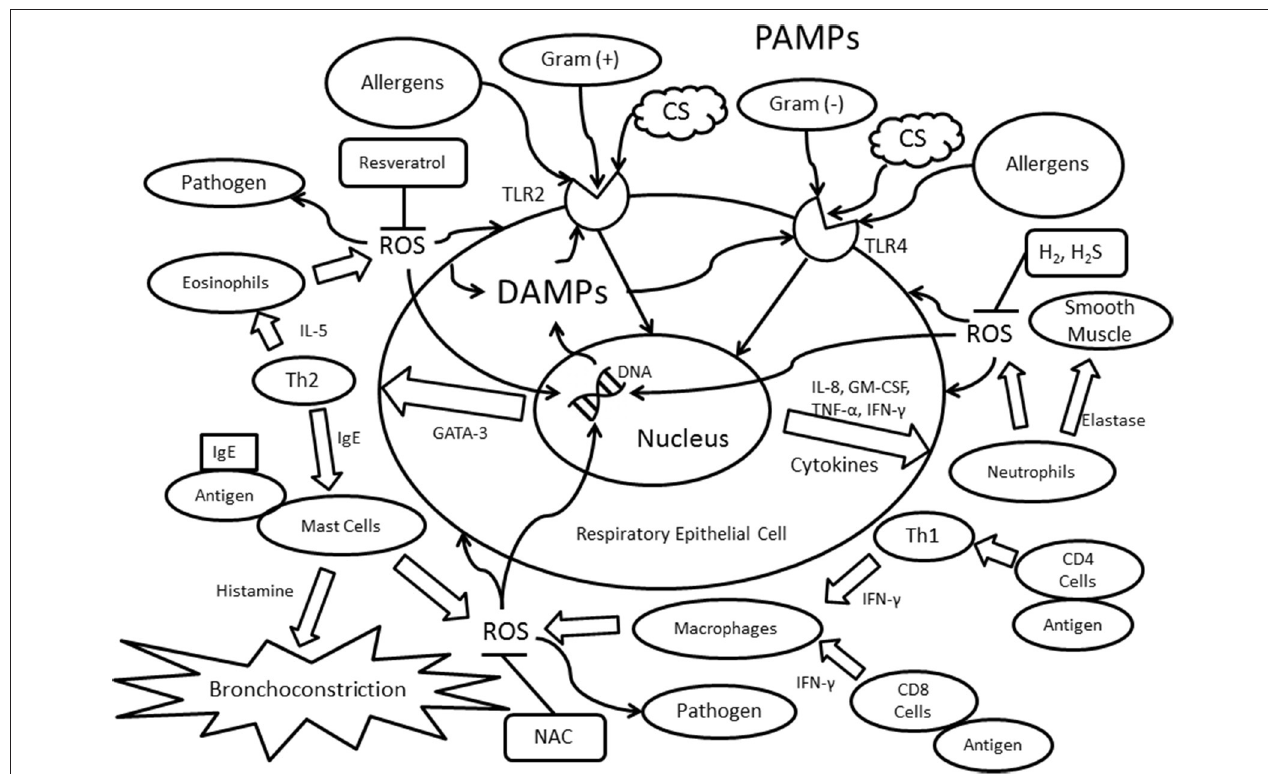
FIGURE 1 | Immunological mechanisms involving TLR2/TLR4 and Th1/Th2 immunity. Abbreviations: PAMPs, pathogen-associated molecular patterns; ROS, reactive oxygen species; IL, interleukin; IFN- γ , interferon- γ ; TLR, toll-like receptor; CS, cigarette smoke; CD4, cluster of differentiation 4; CD8, cluster of differentiation 8; Th1, T helper cell type 1; Th2, T helper cell type 2; Gram ( − ), gram-negative bacteria; Gram ( + ), gram-positive bacteria; IgE, Immunoglobulin E; GATA-3, GATA binding protein 3; TNF- α , tumor necrosis factor- α ; GM-CSF, Granulocyte-macrophage colony-stimulating factor; NAC, N-Acetyl-L-cysteine; H 2 , molecular hydrogen; H 2 S, dihydrogen